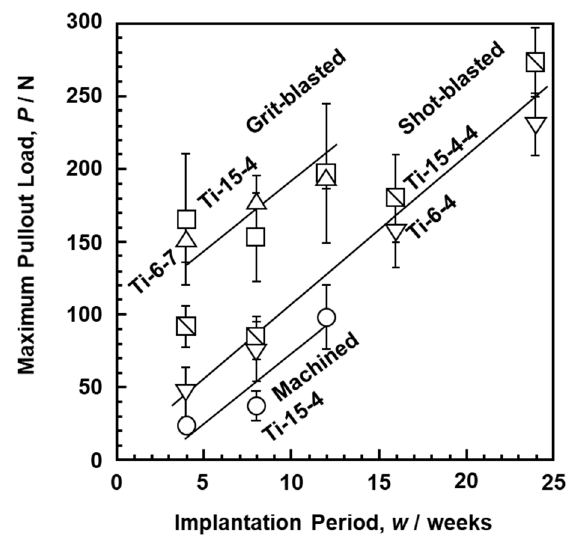
Figure 7. Maximum pullout loads after implantation in rabbits.